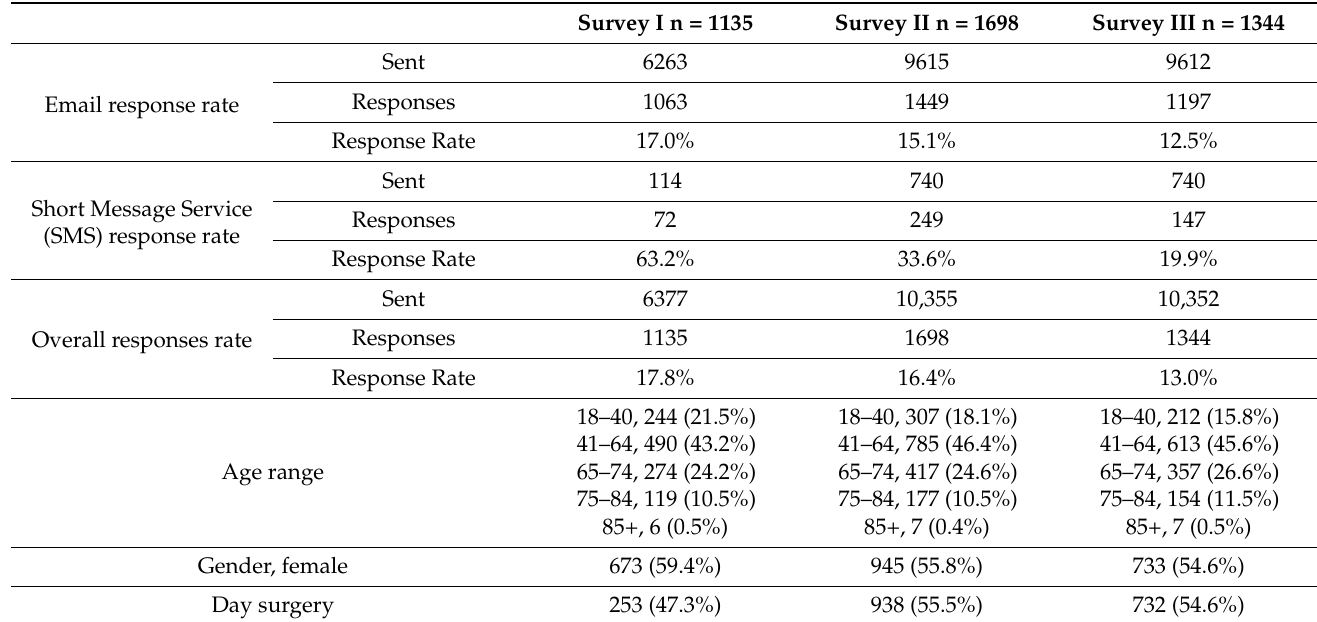
Table 1. Response rate and patient characteristics for surveys I, II and